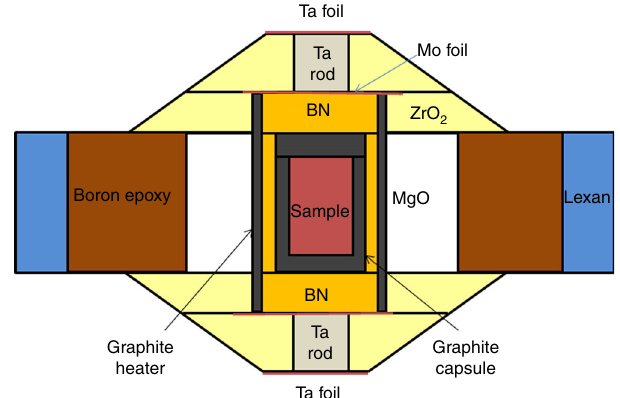
Fig. 1 The cell assembly for Paris – Edinburgh press used in phase and structure measurements of CaCO 3 . The CaCO 3 sample is loaded in a graphite capsule which is isolated from a graphite heater by a BN pressure medium. The graphite heater is connected by Mo foils and Ta rods which serve as electrodes. MgO serves as both pressure calibrate and pressure